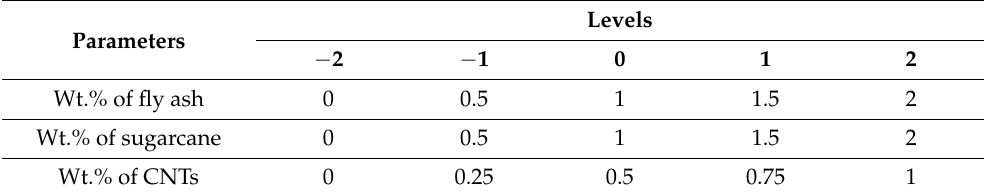
(SHIMADZU make AG-X plus, Shimadzu Asia Pacific, Pvt.Ltd, Chennai, Tamilnadu, In-